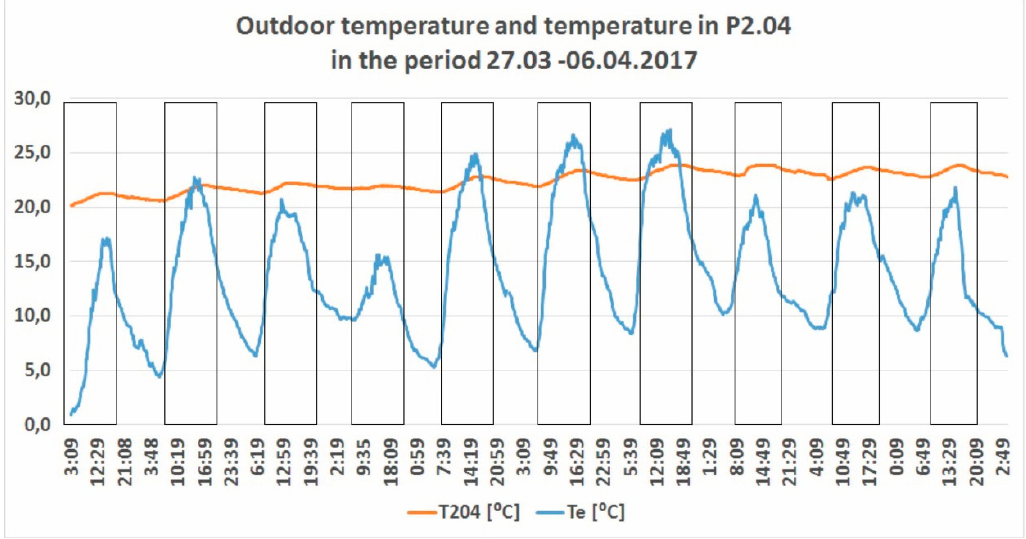
Figure 11. Wavelength of external radiation and indoor temperature in room P2.04—with external sun shading devices.